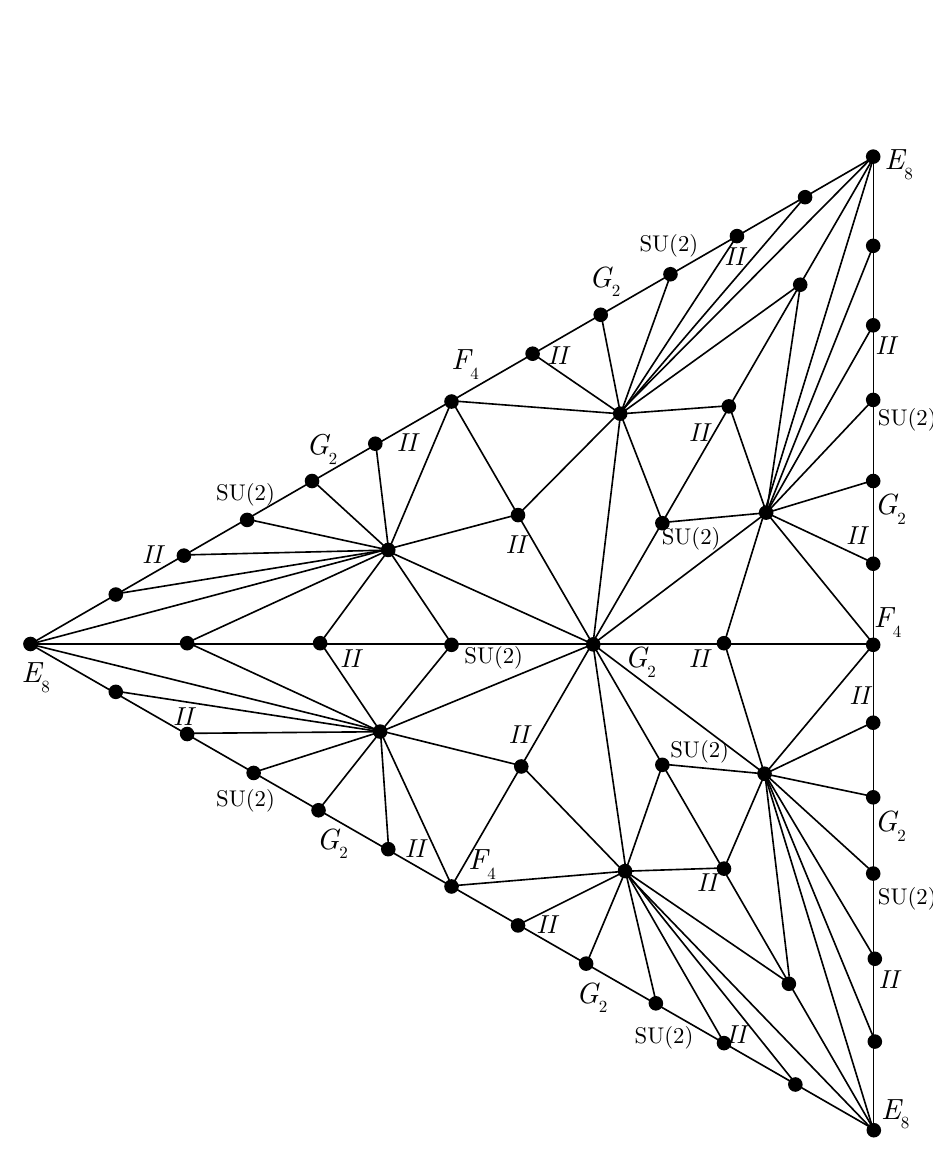
Figure 5 . The fully blown up ( E 8 , E 8 , E 8 )